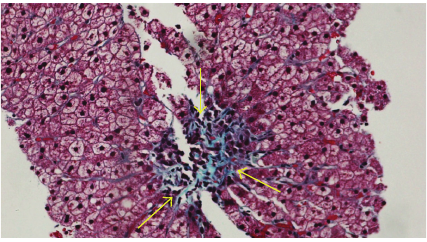
Figure 2: Trichrome staining revealed centrilobular fibrosis